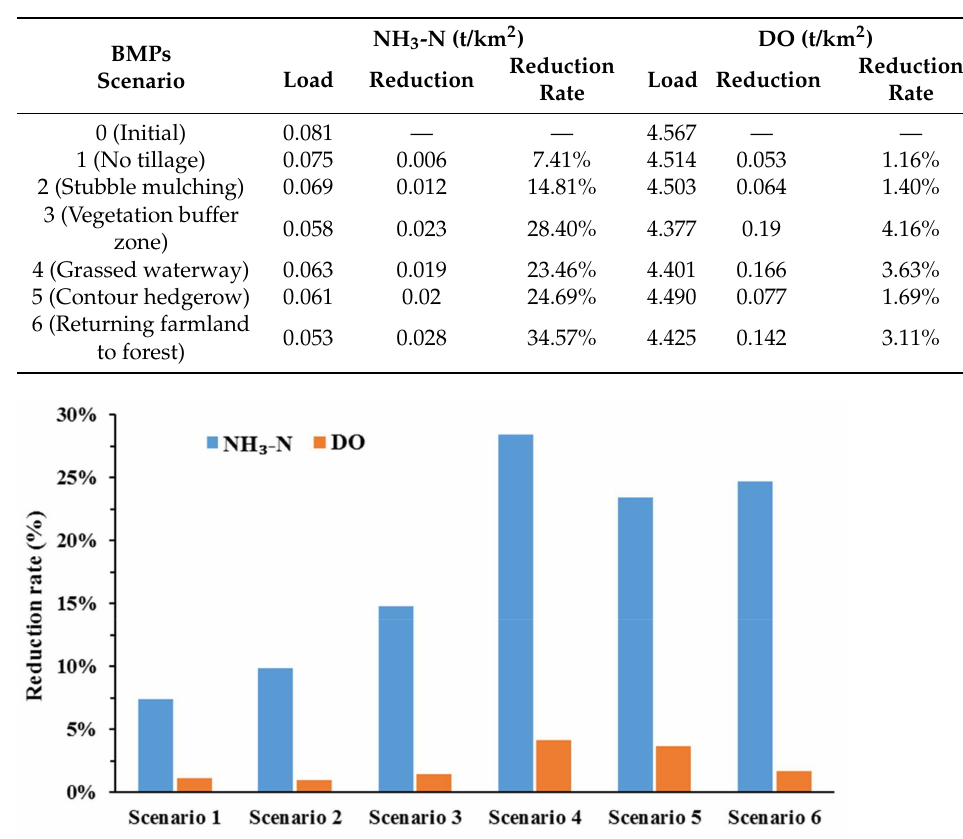
Table 8. The rates of NH 3 -N and DO reductions by implementing BMPs in different scenarios.